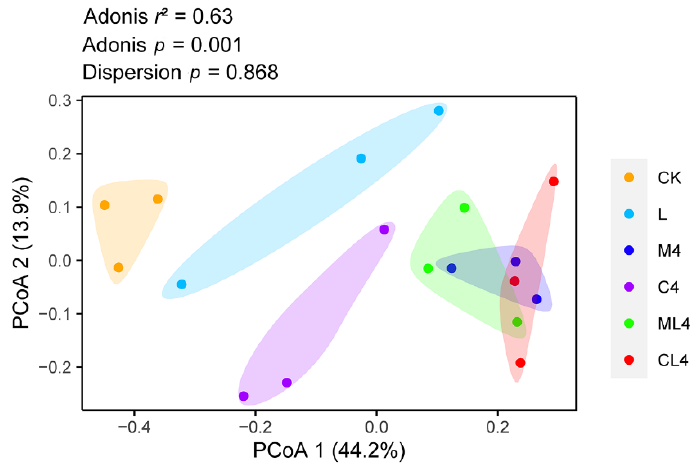
Figure 3. Principal Coordinates Analysis (PCoA) plot based on the Bray–Curtis dissimilarity matrix of the bacterial community among treatments. Adonis: permutational